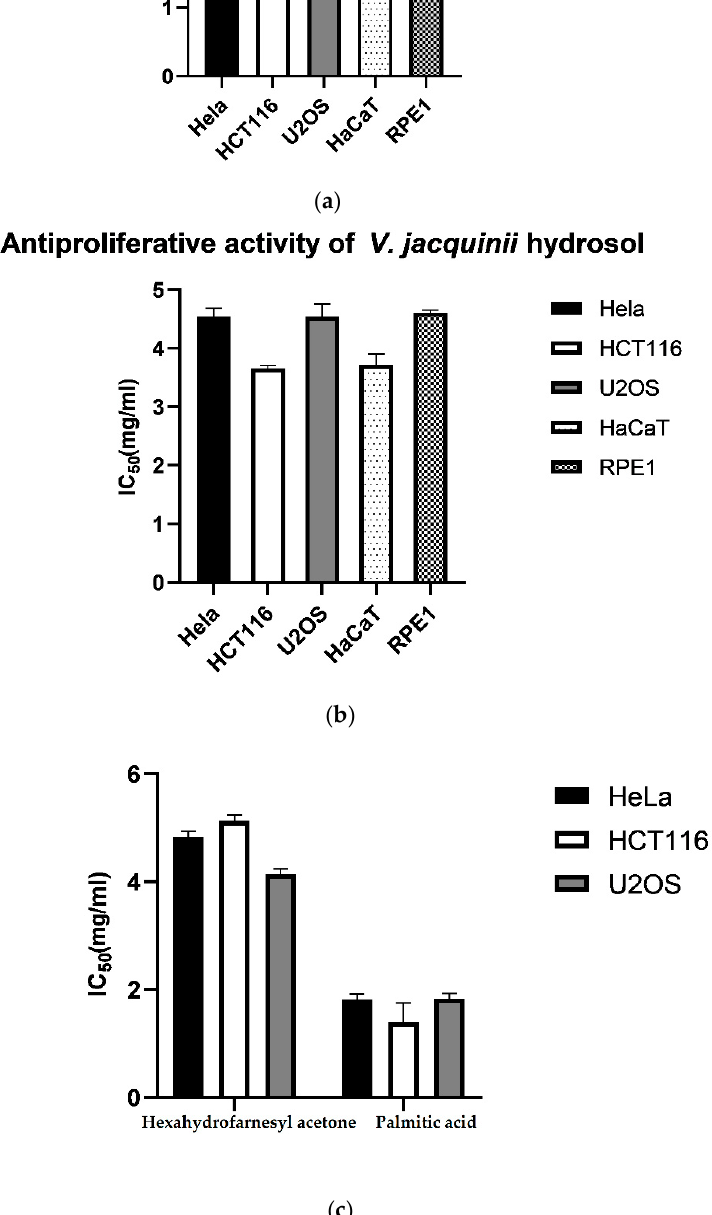
Figure 5. Antiproliferative activity of: ( a ) V. austriaca ssp. jacquinii EO; ( b ) V. austriaca ssp. jacquinii hydrosol; ( c ) Standards of the most abundant compounds.